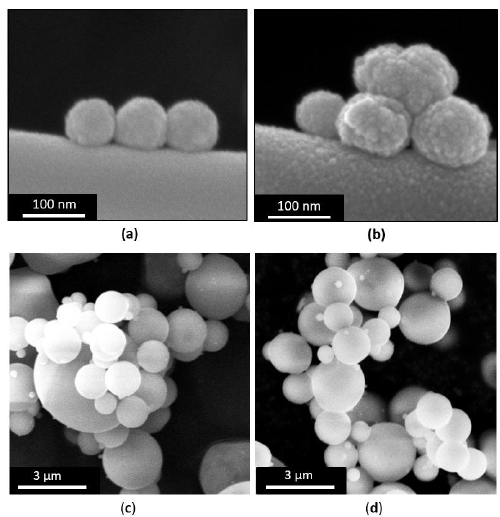
Figure 1. FE-SEM images of ( a ) MBG_Sr2%_SG; ( b ) MBG_Sr4%_SG; ( c ) MBG_Sr2%_SD; ( d ) MBG_Sr4%_SD.